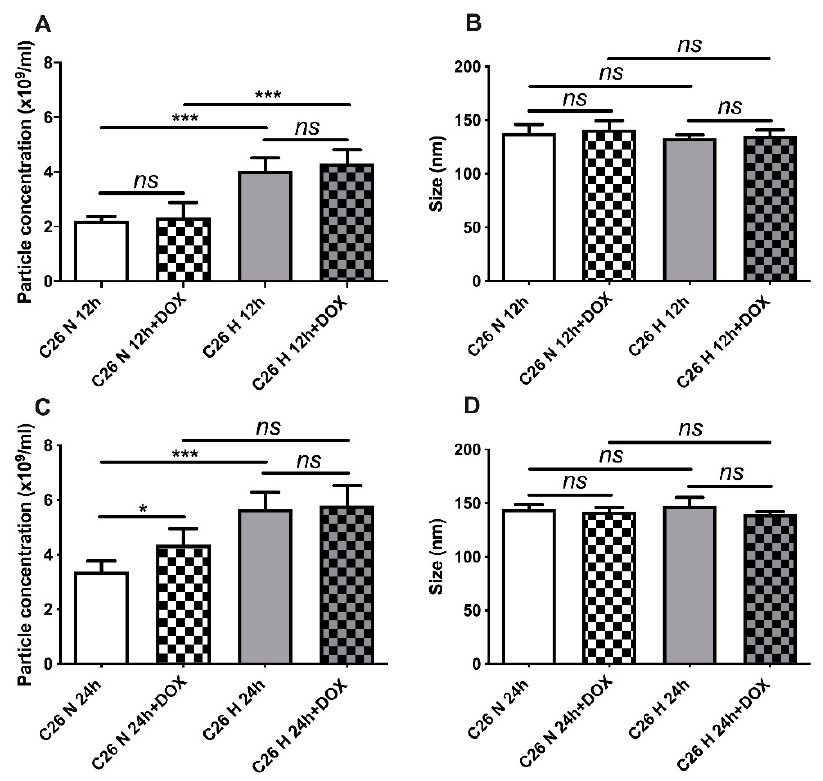
Figure 3. Size distribution and concentration of TEV. Nanoparticle tracking analysis was used to determine TEV concentration ( A ) and their size ( B ) under normoxia and hypoxia after 12 h incubation with 0.3 µ M DOX. The production ( C ) and size ( D ) of extracellular vesicles (EVs) secreted by C26 cells after 24 h incubation with 0.3 µ M DOX under normoxia and hypoxia are also shown. EV production was expressed as particle concentration / mL ± SD of triplicate measurements and data were normalised for the protein concentration obtained from cell lysates at the time of EV harvesting; ns : not significant, p > 0.05; *, p < 0.05; ***, p < 0.001.